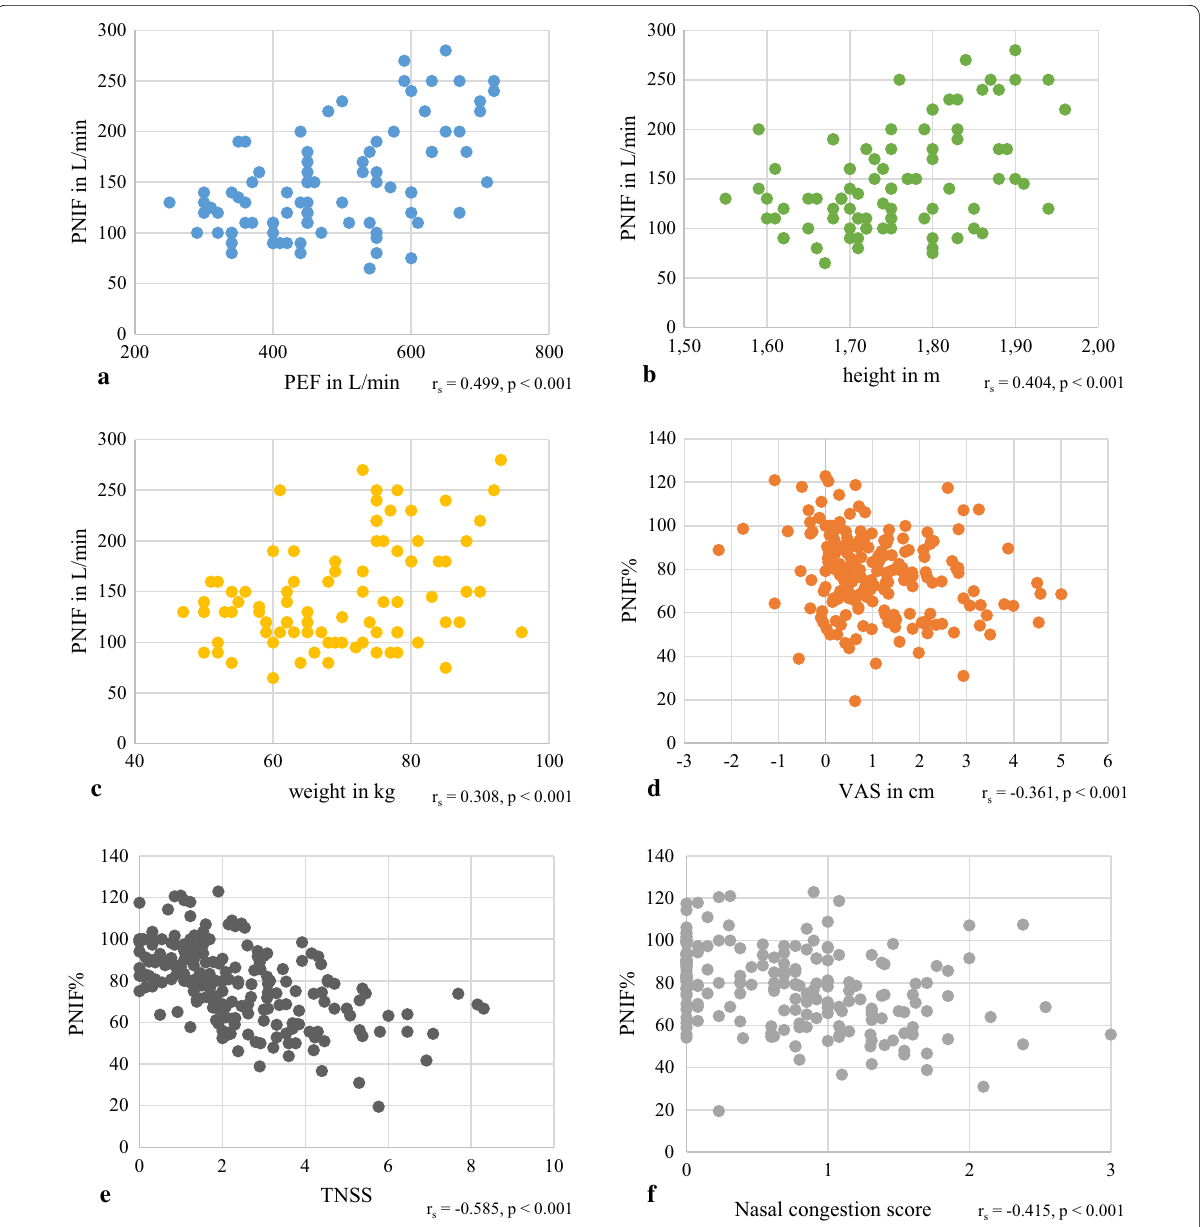
Fig. 4 Correlations between peak nasal inspiratory flow (PNIF) and oral peak expiratory flow (PEF) ( a ), height ( b ), and weight ( c ) with n relative peak nasal inspiratory flow compared to baseline (PNIF%) and mean VAS change from baseline ( d ), mean Total Nasal Symptom Score (TNSS) ( e ), and mean nasal congestion score ( f ) with n =